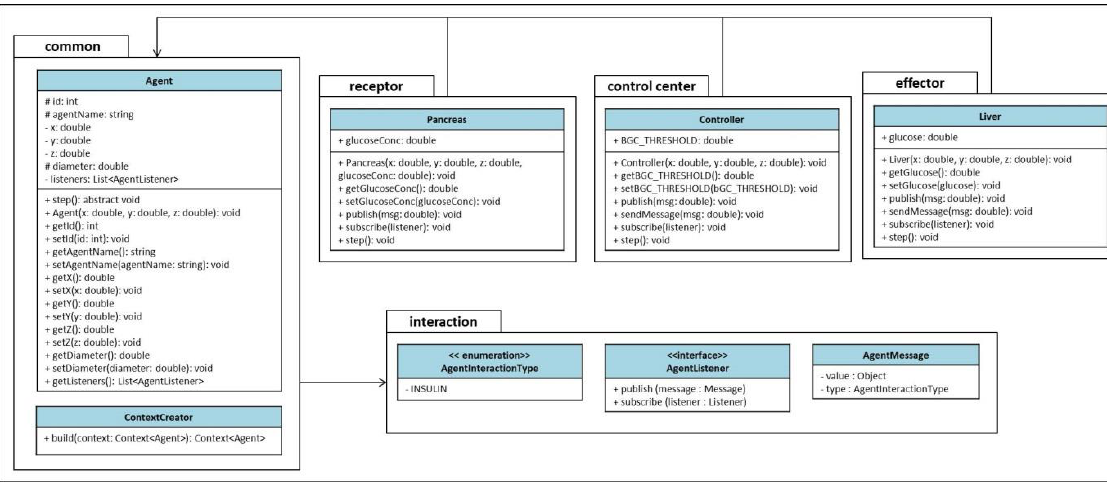
Figure 3. UML class diagram that shown agents and their interactions